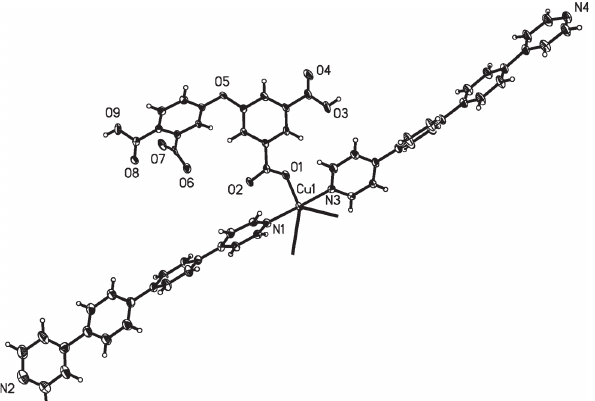
Table 2: Fractional atomic coordinates and isotropic or equivalent isotropic displacement parameters (Å 2